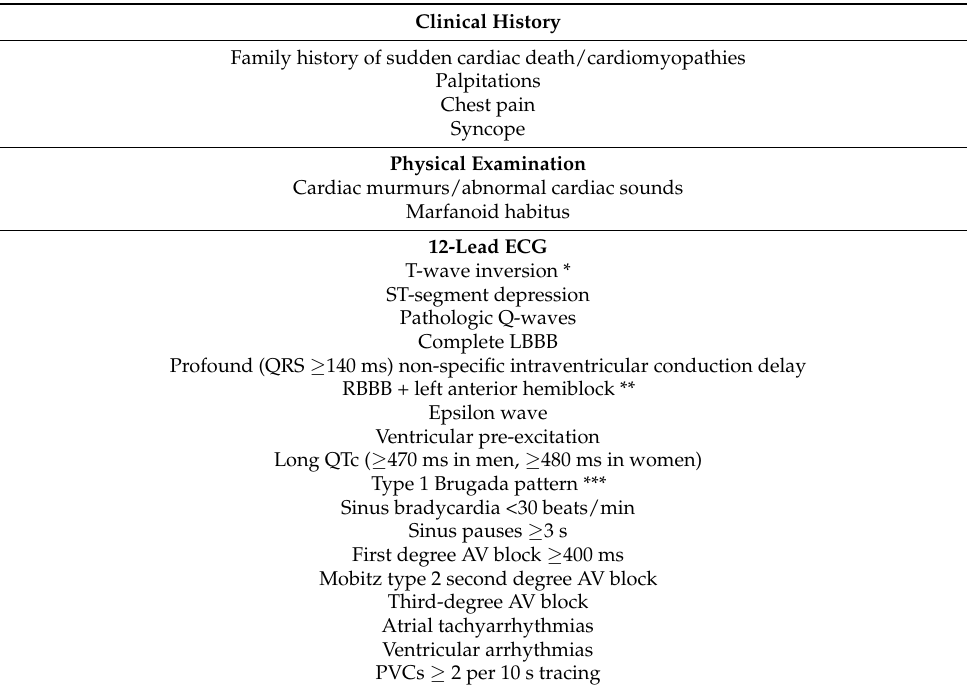
Table 1. Athlete’s clinical and electrocardiographic features requiring further